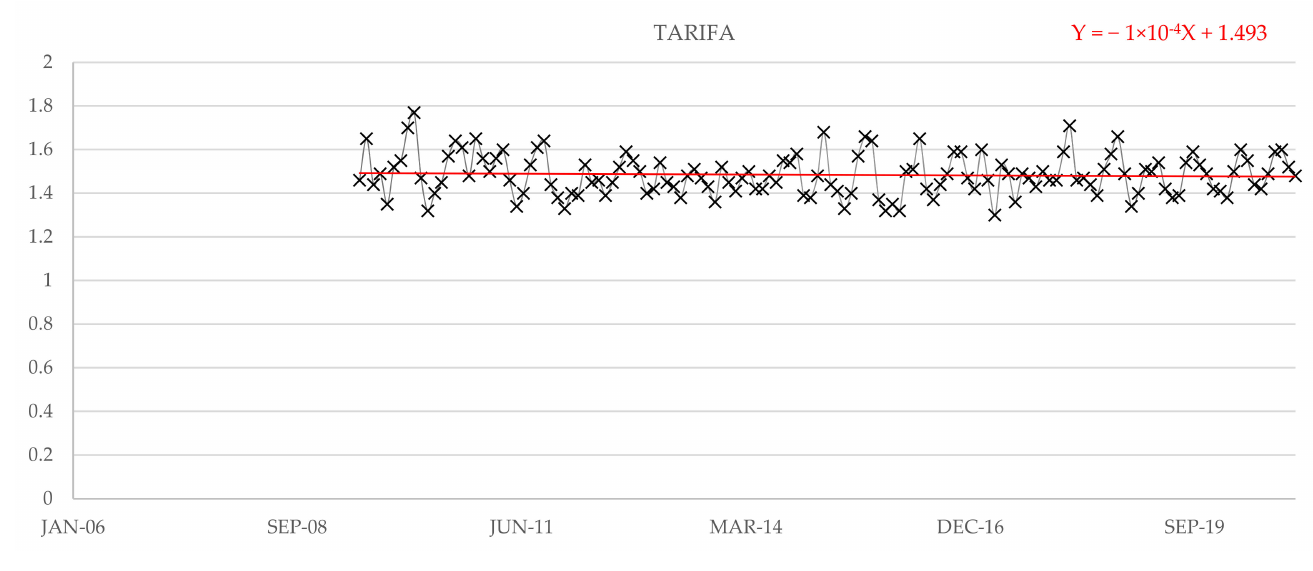
Figure 33. Evolution of SL maxima in Tarifa.